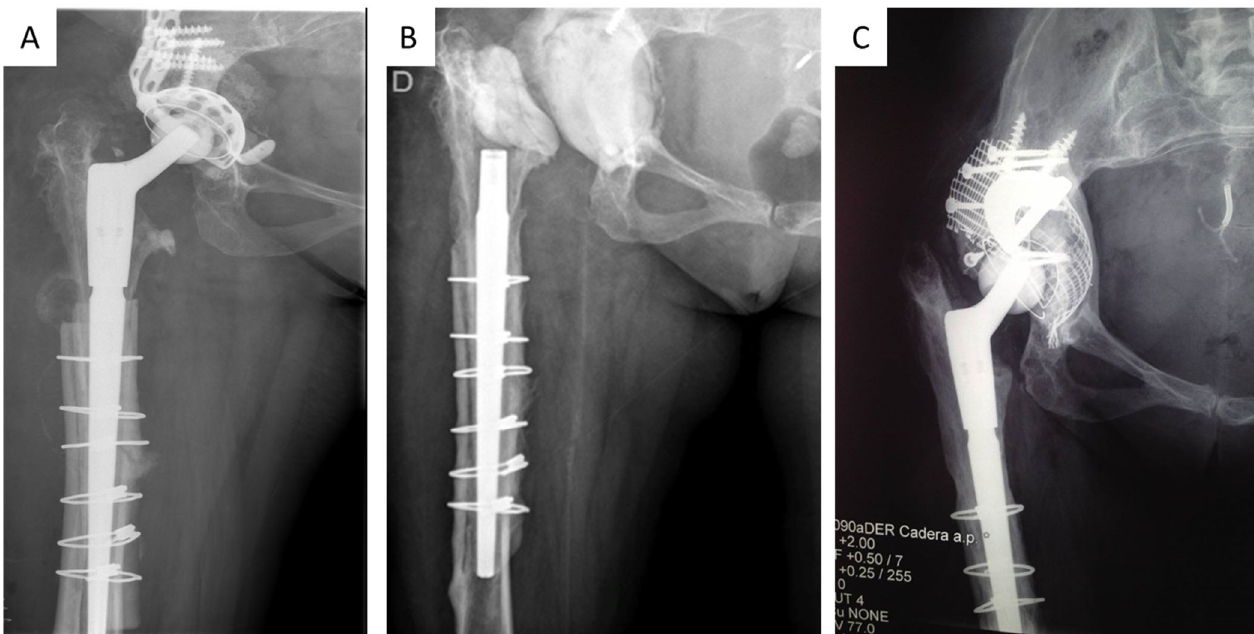
Figure 1. ( A ), Preoperative radiograph before the first stage in a patient with septic loosening of acetabular component; ( B ), radiograph with a non ‐ articulated spacer; ( C ), radiograph at 9 ‐ year follow ‐ up after the second stage with bone impaction grafting and trabecular metal augments (BIG ‐ TMT).